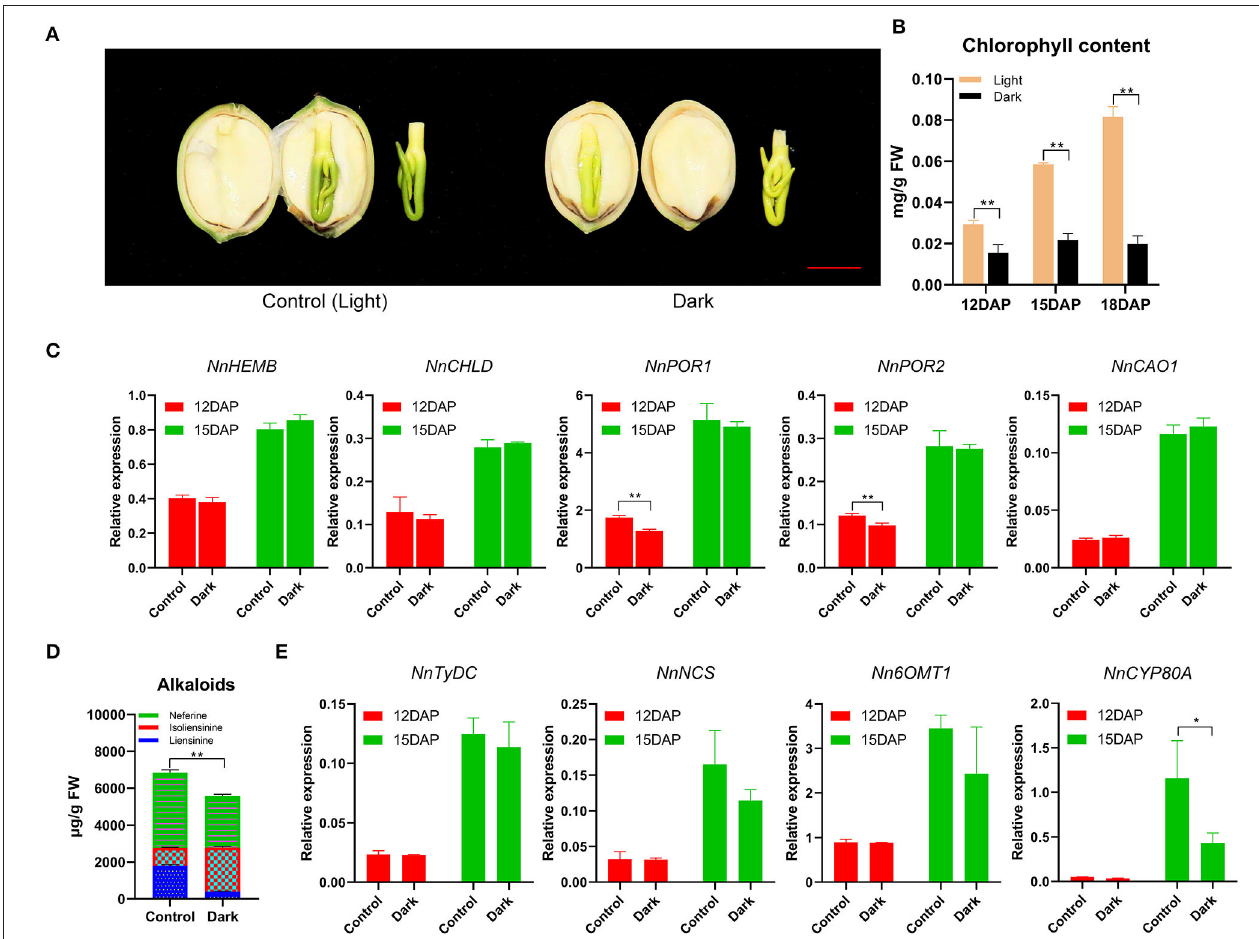
FIGURE 6 | The biosynthesis of Chl and alkaloids in lotus plumule is inhibited under dark treatment. (A) Phenotypes of 18 DAP lotus plumule under control (left) and dark treatments (right). The red bar represents 1cm. (B) Chl content in lotus plumule under light and dark treatments. Bars represent means ± standard error ( n = 4). ** P ≤ 0.01. (C) Expression patterns of Chl biosynthesis genes under light and dark conditions. Bars represent means ± standard error ( n = 3). ** P ≤ 0.01. (D) Alkaloid content in lotus plumule under light and dark conditions. Bars represent means ± standard error ( n = 4). ** P ≤ 0.01. (E) Expression patterns of selected alkaloid biosynthesis genes under light and dark conditions. Bars represent means ± standard error ( n = 3). * P ≤